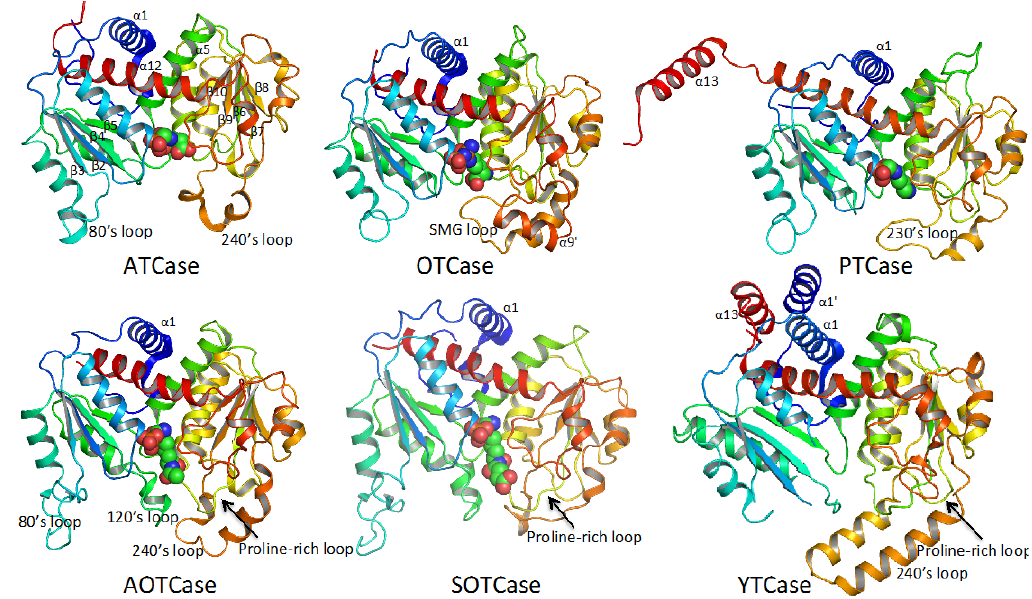
Figure 3. Ribbon diagram of the catalytic subunit of Escherichia coli ATCase, E. coli OTCase, Enterococus faecalis PTCase, Xanthomonas campestris AOTCase, Bacteroides fragilis SOTCase and E. coli YTCase. The ribbons are colored in rainbow from blue (N-terminus) to red (C-terminus). The bound substrates or inhibitors are shown in space-filling models. The 3 1 trefoil knots are formed by residues at the C-terminal end threading through the proline-rich loop (indicated by arrows) in AOTCase, SOTCase and